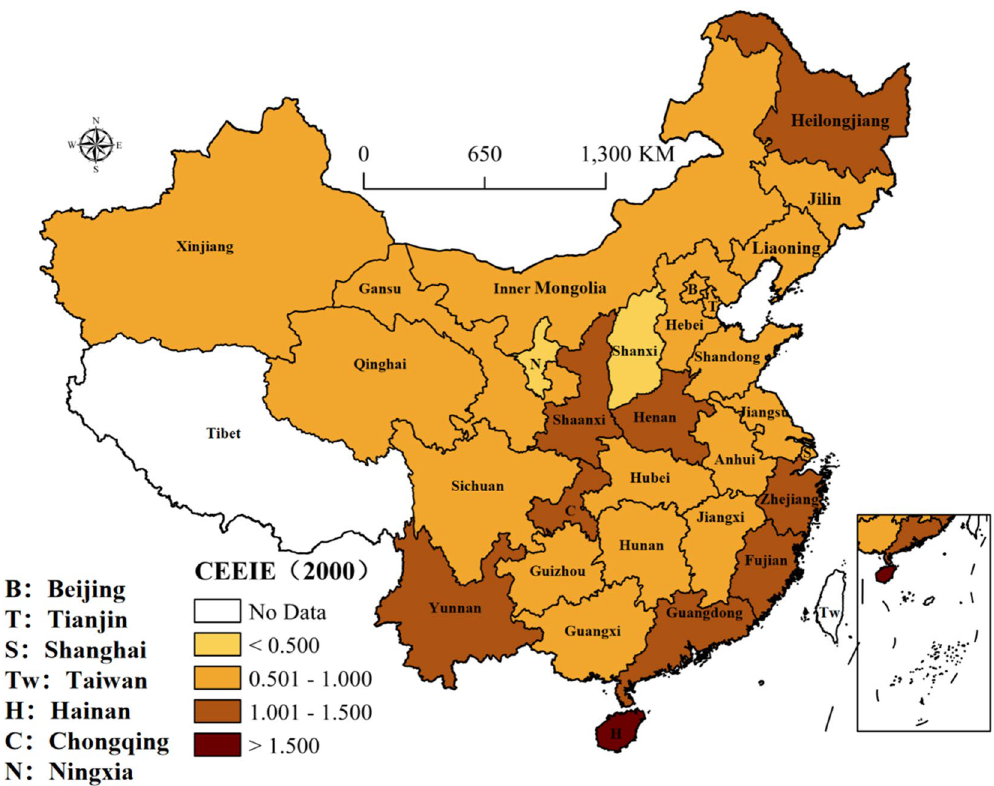
Figure 1. The distribution of CEEIE in 2000 (prepared by KL in ArcGIS Pro, https:// www. esri. com/ zh- cn/ arcgis/ produ cts/ arcgis- pro/ resou